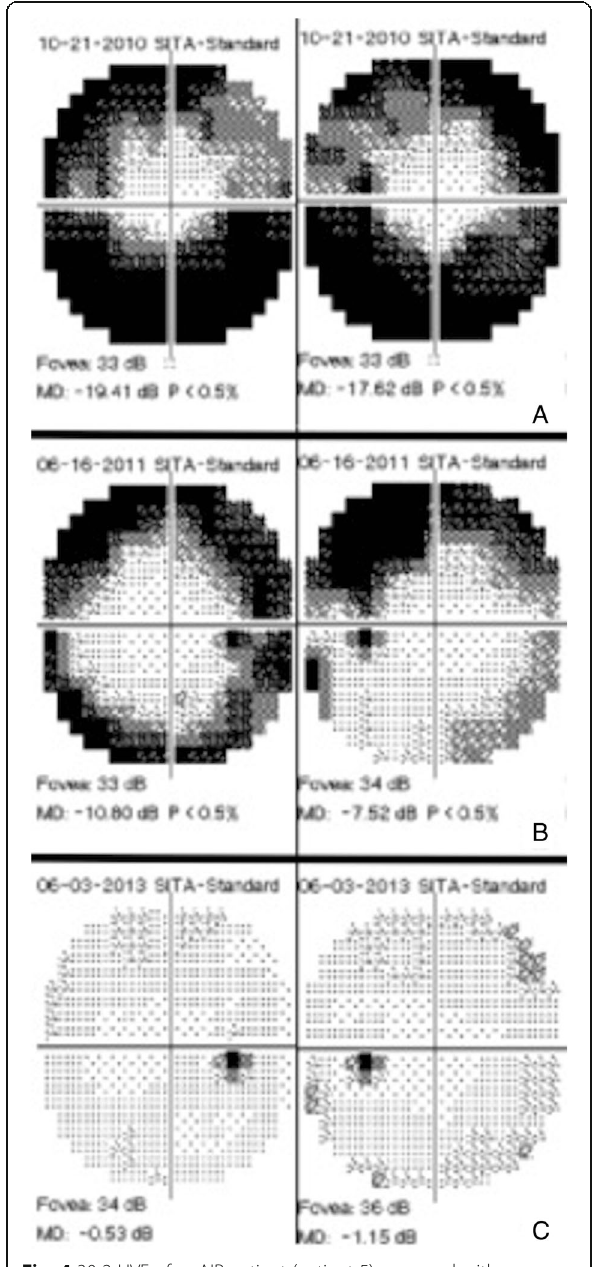
Fig. 4 30-2 HVF of npAIR patient (patient 5) managed with valacyclovir. a Field defects at presentation. b Partial recovery of the visual fields after a 4-week course of treatment with valacyclovir. c Resolution of visual field defects at most recent follow-up (3 years after